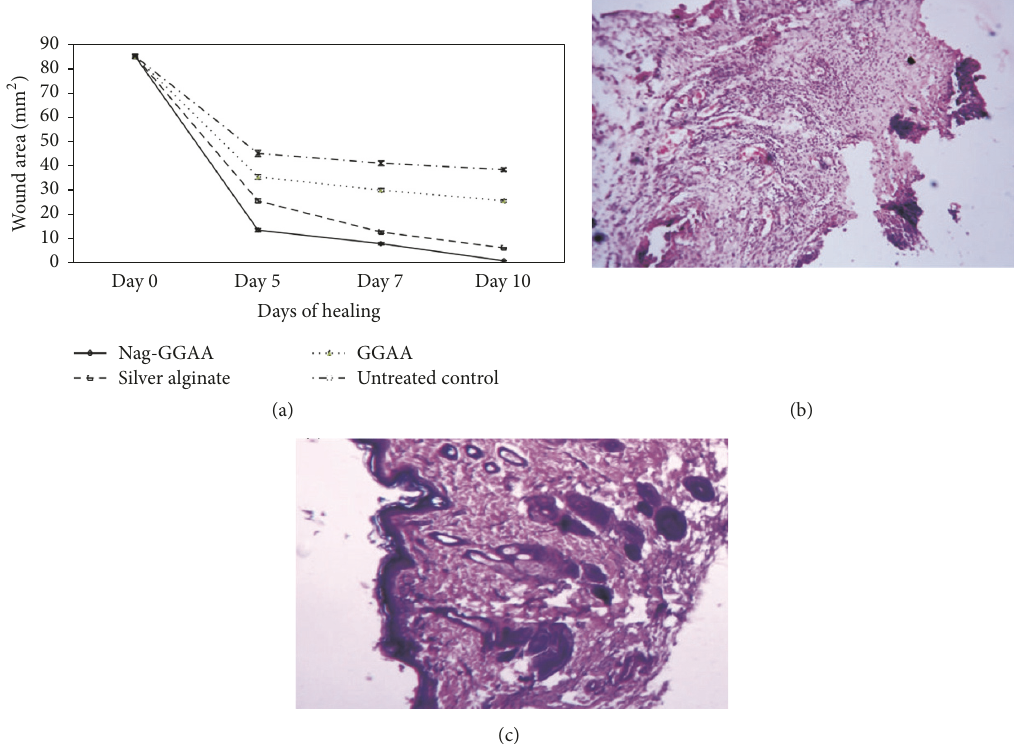
Figure 2: (a) Effect of wound closure on silver alginate guar gum alkylamine nanoparticles and other positive controls, (b) histological examination of control (without treatment) tissue, and (c) histological examination of tissue treated with silver alginate guar gum alkylamine nanoparticles [26] (figure obtained from an open access article distributed under the Creative Commons Attribution License).